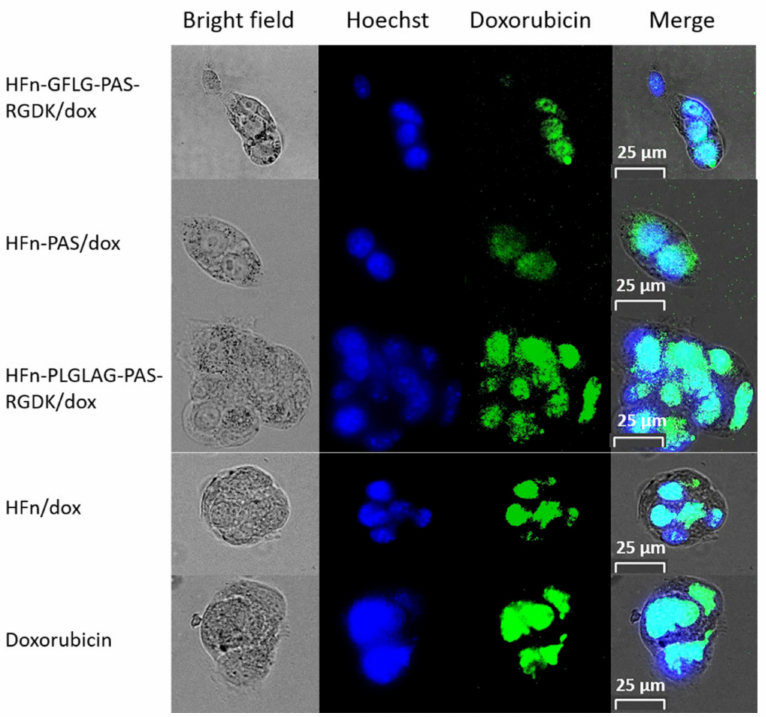
Figure 3. Intracellular distribution of DOX in 4T1 cells. Under the Bio-Rad Zoe cell imager, blue: nucleus after being stained with Hoechst 33258. Green: DOX because of its intrinsic fluorescence. Cyan: merged florescence signal.